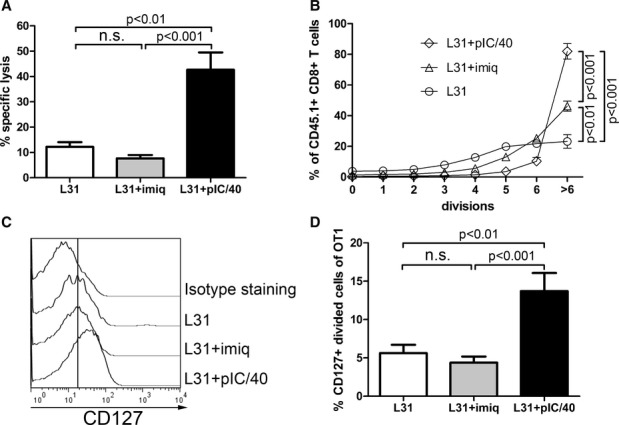
Langerin targeting with poly(I:C) and anti-CD40 efficiently triggers CD8+ T-cell responsesA In vivo killing of OVA-loaded target cells. C57BL/6 mice were immunized i.d. into both ears with 0.5 μg Langerin/OVA (L31) alone or in addition to imiquimod (+imiq) or poly(I:C) and anti-CD40 (+pIC/40). Seven days later, CFSE-labeled OVA-loaded target cells and CTO-labeled unloaded control cells were transferred i.v. Specific lysis of OVA-loaded target cells was measured in the blood 2 days later. Values from individually analyzed mice are pooled from two independent experiments (L31: three mice; L31+imiq: 10 mice; L31+pIC/40: six mice) and compared using one-way ANOVA (P < 0.0001) followed by Tukey's test (n.s.: non-significant, P > 0.05).B–D Proliferation and differentiation of OVA-specific transgenic CD8+ T cells. CD8+ T cells purified from [OT-I × Ly5.1] F1 mice were labeled with CFSE and injected i.v. into C57BL/6 mice. The next day, mice were immunized i.d. into both ears with 0.5 μg Langerin/OVA (L31) alone or in addition to imiquimod (+imiq) or poly(I:C) and anti-CD40 (+pIC/40). Six days later, skin-draining lymph nodes were digested, and CD45.1+ CD8+ T cells were analyzed by flow cytometry for proliferation and expression of IL-7R/CD127. Values from individually analyzed mice are pooled from three independent experiments (L31: six mice; L31+imiq: nine mice; L31+pIC/40: five mice) and compared using one-way ANOVA followed by Tukey's test (n.s.: non-significant, P > 0.05). (B) Proportions of cells that underwent 0–6 or more cycles of division (ANOVA: P < 0.0001). (C) Representative histogram plots of CD127 stainings. The vertical line depicts the geometric mean intensity of fluorescence when immunizing with Langerin/OVA alone. (D) Proportion of CD127+ divided cells (ANOVA: P = 0.0004).